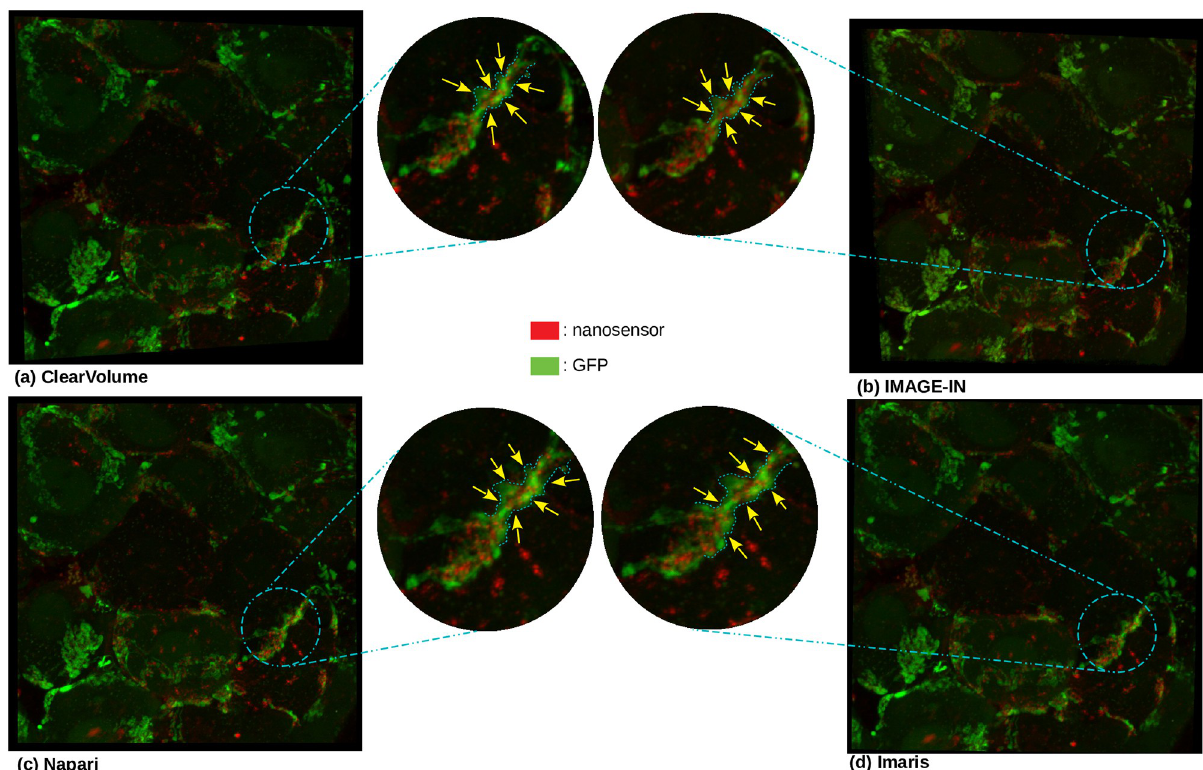
Fig 8. The two-channel submandibular ganglion [45] CLSM dataset is rendered in 3D volume on the following viewers: (a) Clearvolume (the ImageJ open-source desktop viewer), (b) IMAGE-IN (the web visualizer), (c) Napari (the Python desktop visualizer), and (d) Imaris (the closed-source desktop viewer). The yellow arrow on each rendered image indicates the variation in region across four viewers. The image-in viewer reveals more nanosensor (represented by red color) on this specific spot when compared to the other three viewers. This comparison is made in the early phases.